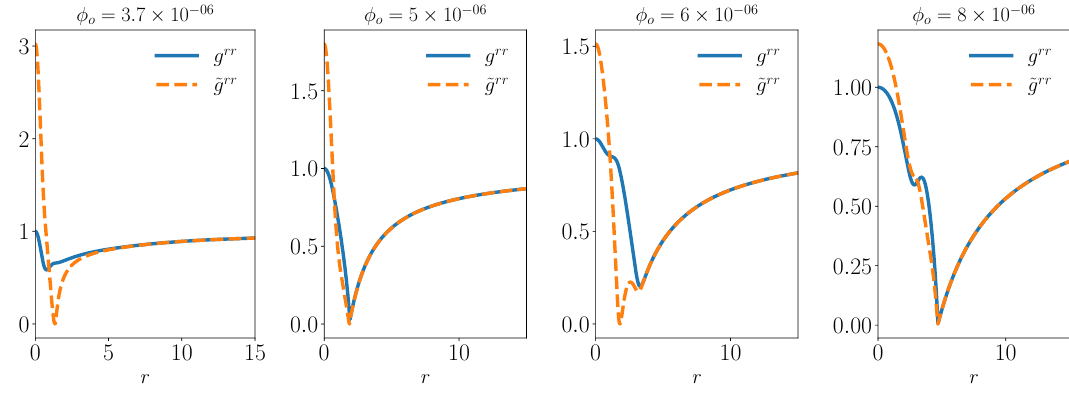
Figure 2 . Last time evolution before formation of a horizon. The event horizon forms when g rr = 0 and the sonic horizon when ~ g rr = 0. For (cid:30) 0 = 3 : 7 10 (cid:0) 6 and (cid:30) 0 = 6 10 (cid:0) 6 forms a sonic horizon while the event horizon is not yet formed, while for (cid:30) 0 = 5 10 (cid:0) 6 and (cid:30) 0 = 8 10 (cid:0) 6 both horizons form at the same time within our numerical